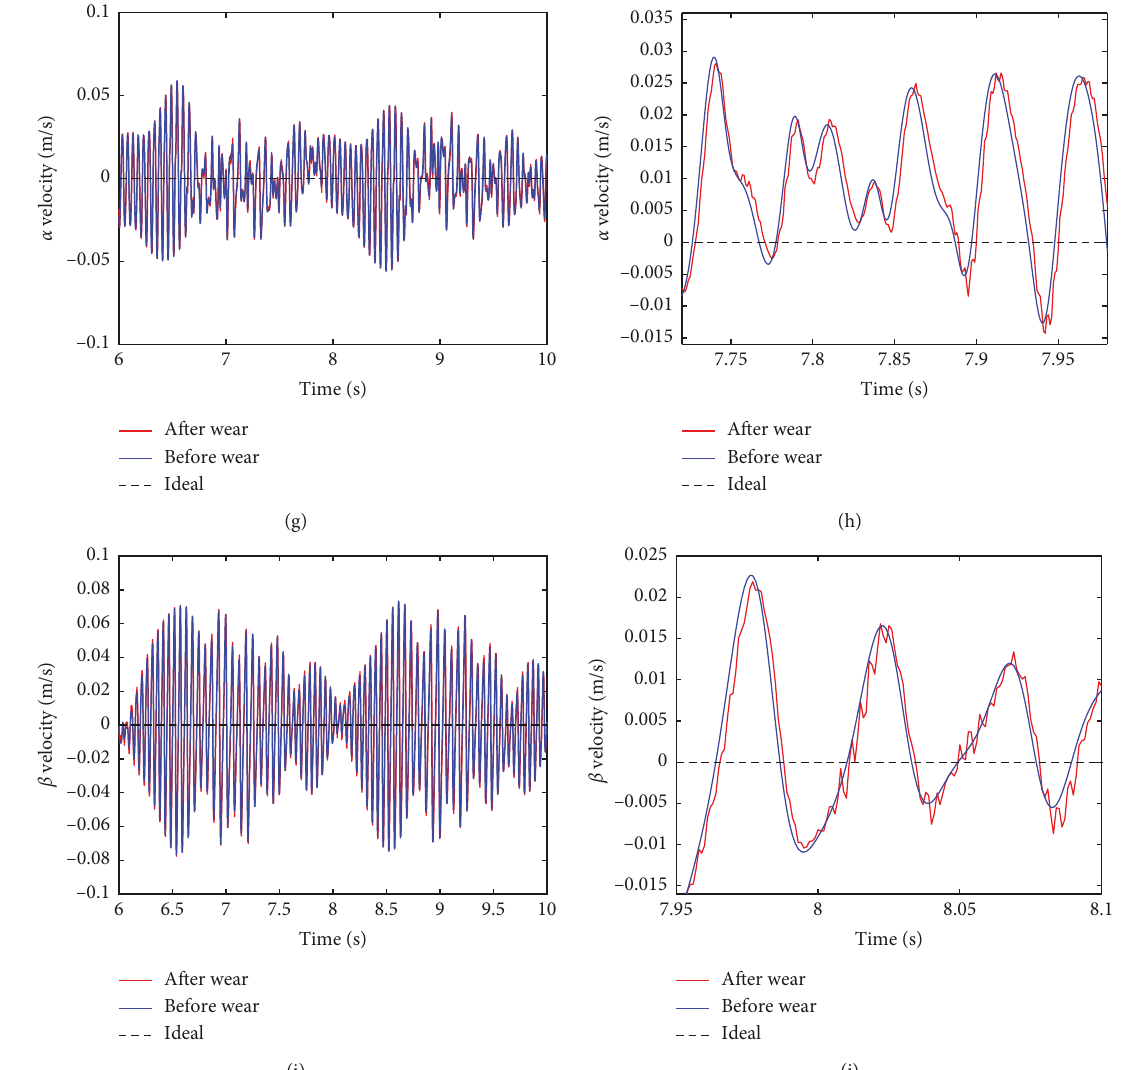
Figure 11: Comparison of velocity curves before and after wear. (a) Velocity curve in X direction, (b) enlarged view of velocity curve in X direction, (c) velocity curve in Y direction, (d) enlarged view of velocity curve in Y direction, (e) velocity curve in Z direction, (f) enlarged view of velocity curve in Z direction, (g) angular velocity curve in α direction, (h) enlarged view of angular velocity curve in α direction, (i) angular velocity curve in β direction, and (j) enlarged view of angular velocity curve in β